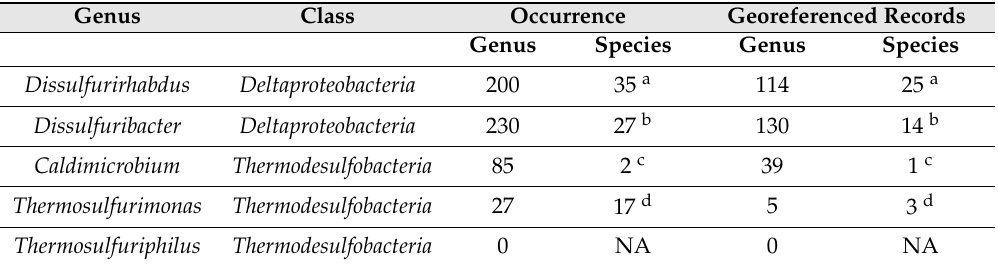
Table 2. Occurrence of the thermophilic sulfur-disproportionating bacteria based on the GBIF (Global Biodiversity Information Facility)